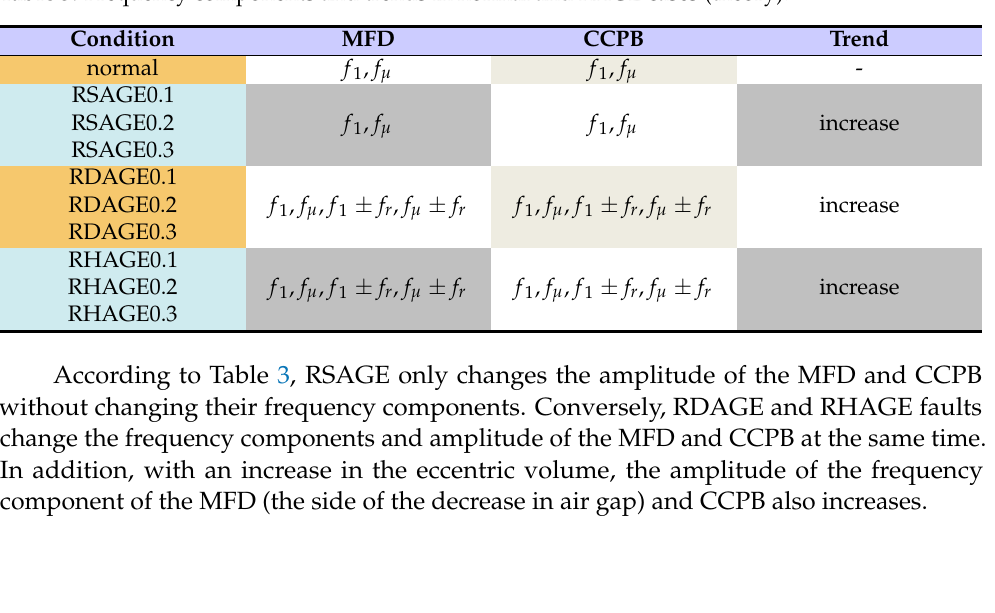
Table 3. Frequency components and trends in normal and RAGE cases